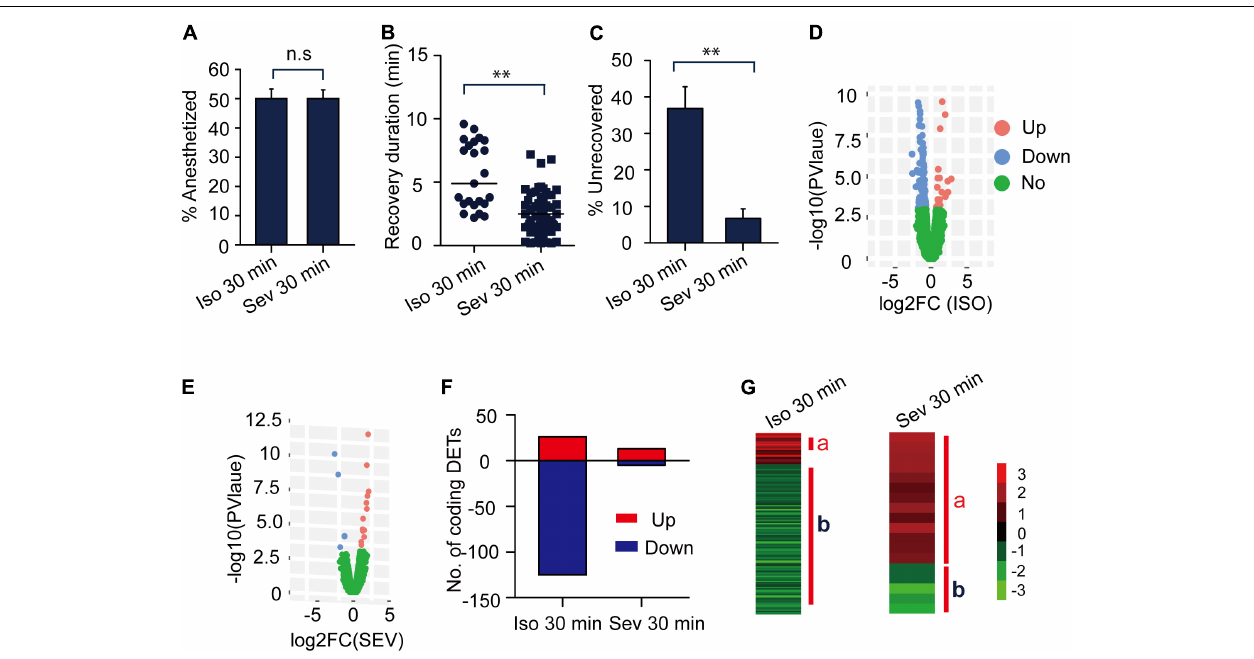
FIGURE 3 | The gene expression profiles of transcripts responding to isoflurane (1.2%) and sevoflurane (3.2%) anesthesia. (A) The anesthesia rate of the migratory locusts responding to 30 min of isoflurane (1.2%) and sevoflurane (3.2%) ( n = 6 groups, and 10 locusts in each group). Percentage of anesthetized locusts is shown as the mean ± SEM. (B) The recovery duration of the migratory locusts after 30 min of isoflurane (1.2%) and sevoflurane (3.2%) exposure ( n = 38 for isoflurane; n = 60 for sevoflurane). (C) The percentage of unrecovered locusts with sevoflurane anesthesia is lower than those insects with isoflurane anesthesia within 10 min after discontinuing anesthesia. (D) The expression profiles of those transcripts in responding to isoflurane anesthesia. (E) The expression profiles of transcripts in responding to sevoflurane anesthesia. (F) Numbers of differentially expressed transcripts (DETs) in response to isoflurane and sevoflurane anesthesia. (G) The DETs induced by 30-min isoflurane and sevoflurane anesthesia were respectively clustered for analyzing gene expression patterns. Student’s t -test is used for analyzing anesthetic responses, and Mann–Whitney U test is used for analyzing the differences of recovery duration from anesthesia. G-test for independence is used for analyzing statistical significance of the differential proportions of unrecovered locusts with isoflurane and sevoflurane anesthesia within 10 min after discontinuing anesthesia. n.s P > 0.05; ∗∗ P < 0.01. JAK, Janus kinase; Iso, isoflurane; Sev,